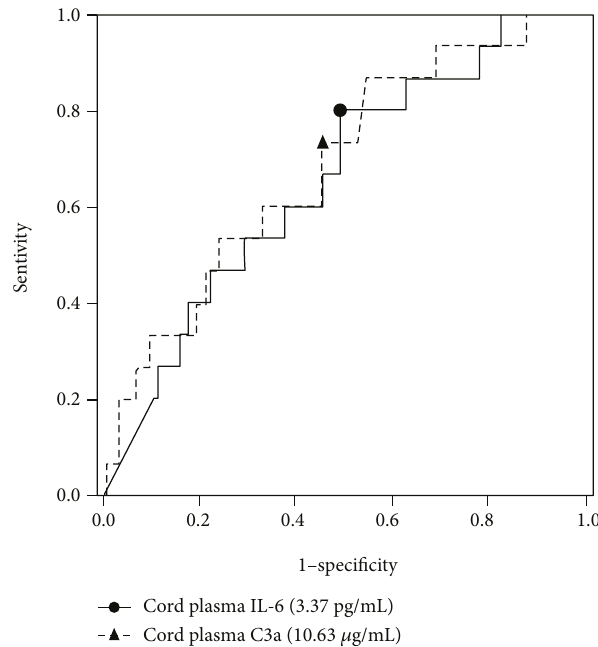
Figure 1: Receiver operating characteristic curves for umbilical cord plasma interleukin-6 (IL-6) “ line ” and C3a “ broken line ” for predicting newborn hearing screening test failure (cord plasma IL-6: area under the curve, 0.663; standard error, 0.070; cord plasma C3a: area under the curve, 0.690; standard error, 0.071; no di ff erences ( P = 0 778 ) between cord plasma IL-6 and